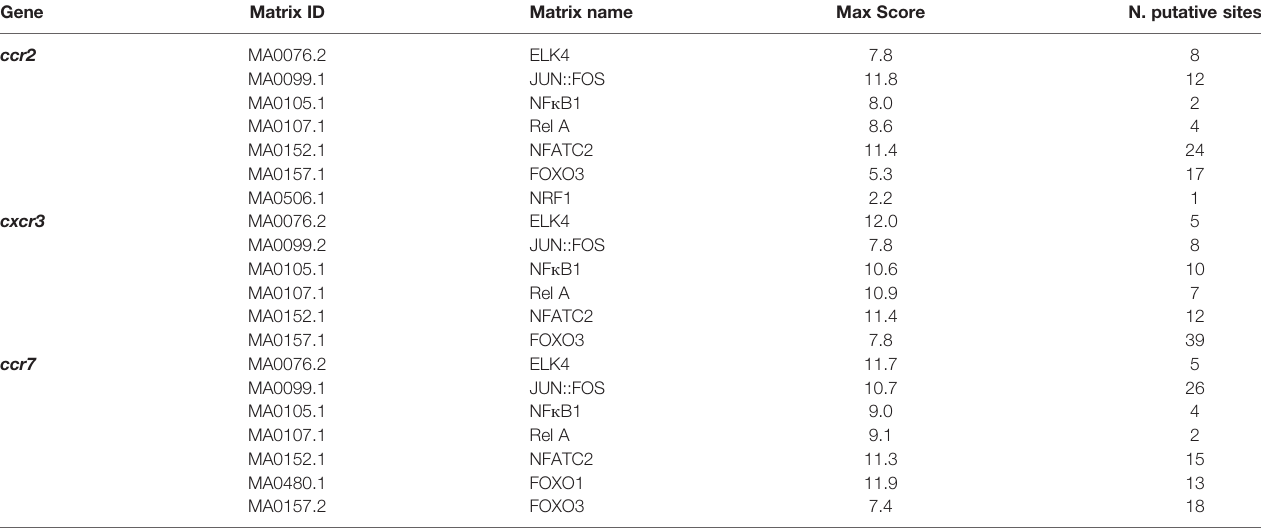
TABLE 1 | List of transcription factors whose putative interaction sites were found in the promoters of the indicated genes. Gene Matrix ID Matrix name Max Score